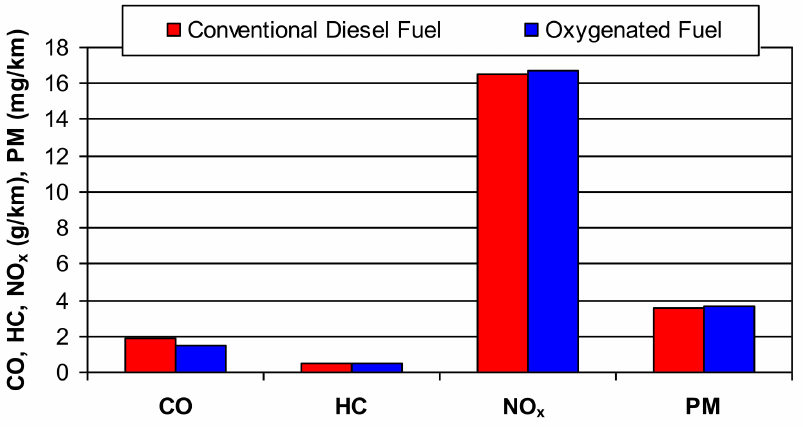
Figure 7. Average road emissions in the SORT 1 cycle from the Solaris Urbino 18 Hybrid bus fuelled by conventional diesel fuel and oxygenated